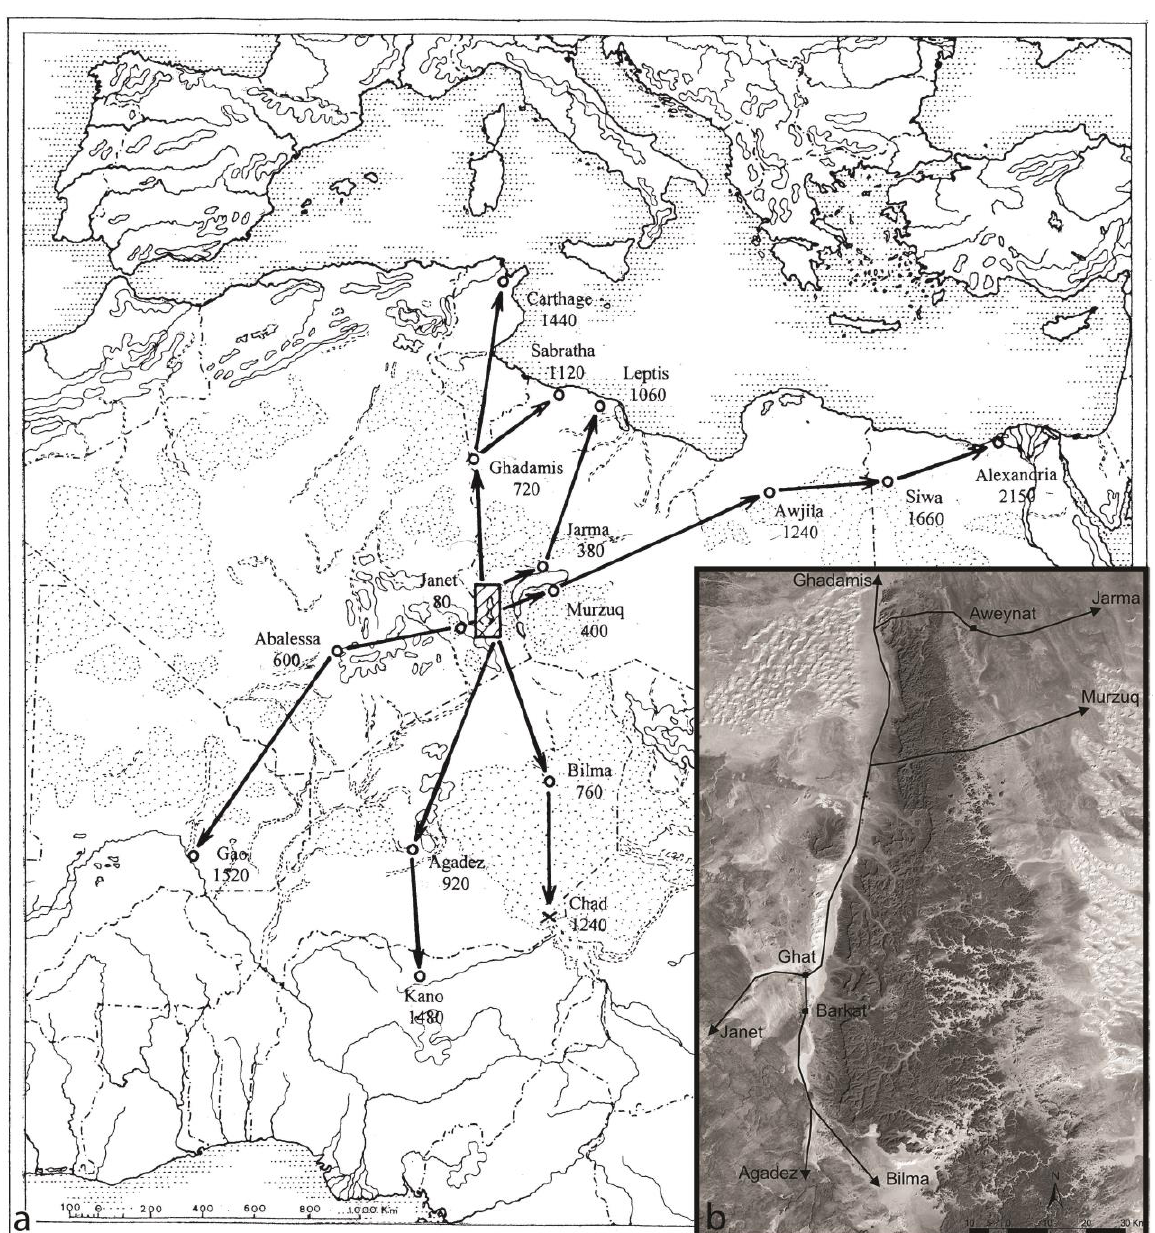
Figure 3. (a) Tadrart Acacsu in the trans-Saharan trade network (after [17]: 451). (b) Detail of the caravan routes (after [17]: